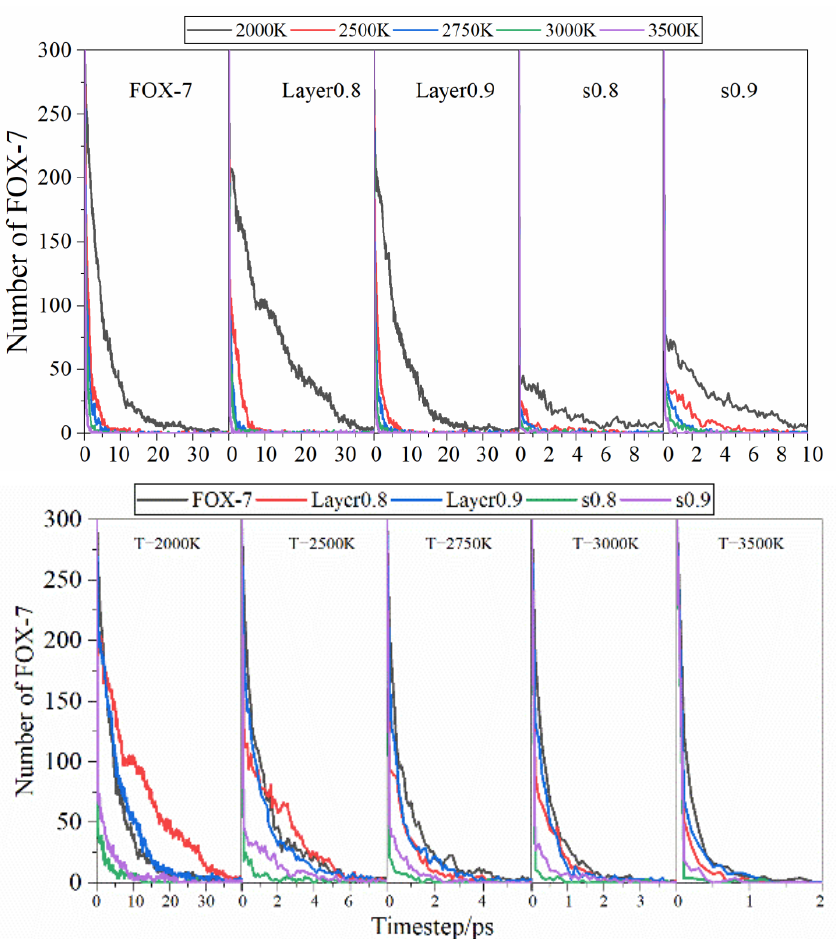
Figure 5. Evolution of the number of the FOX-7 molecules under various conditions.